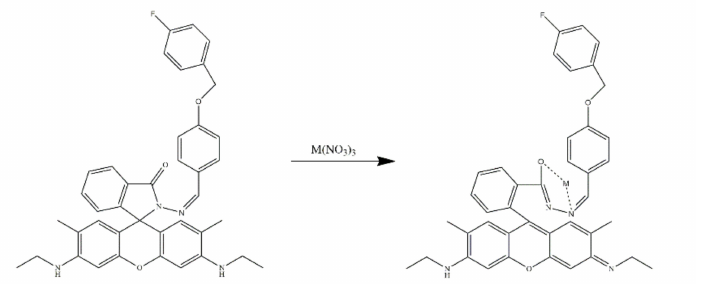
Figure 64. The possible sensing mechanism of the prepared sensor (Table 4, No.19) to Al 3+ , Ga 3+ , In 3+ and Tl 3+